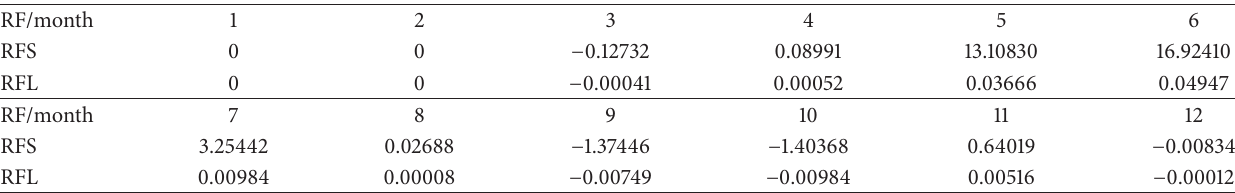
Table 2: The monthly radiative forcing caused by snow cover changes (W/m 2